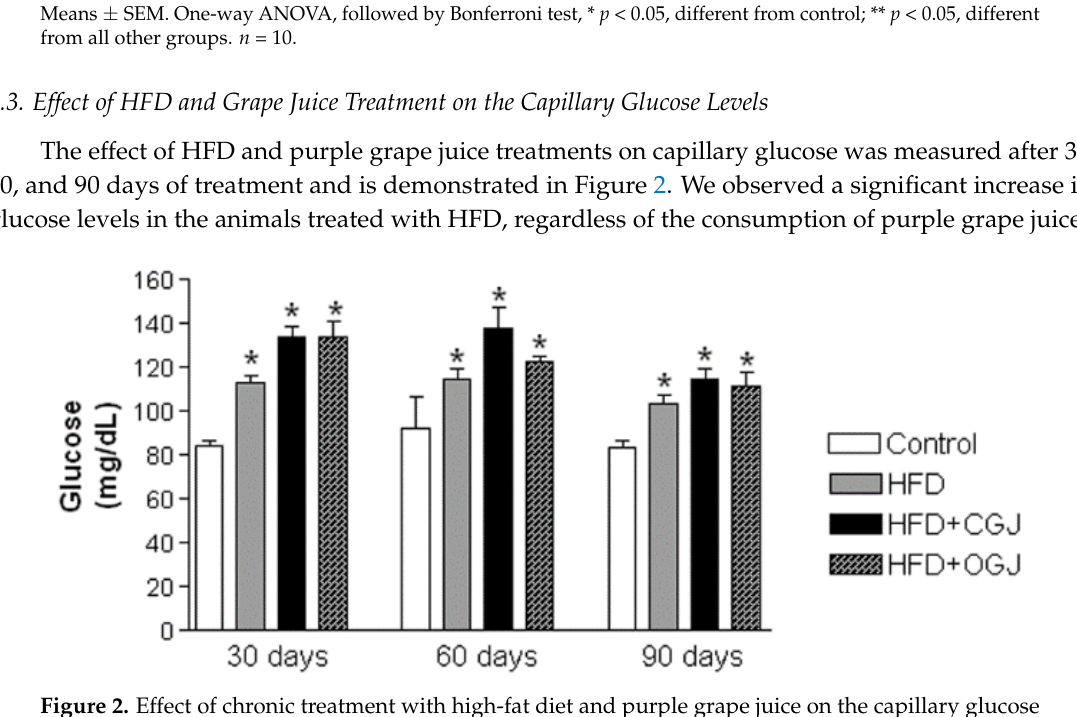
Table 4. Evaluation of biochemical parameters after 12 weeks of treatment with high-fat diet (HFD), conventional grape juice (CGJ), and/or organic grape juice (OGJ).